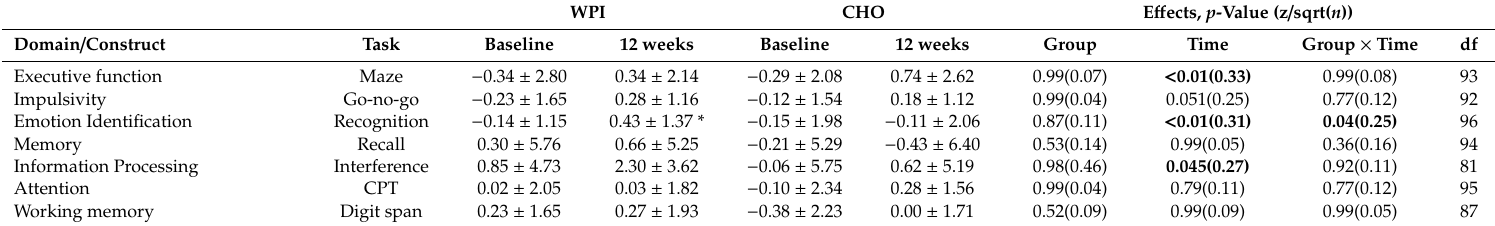
Table 5. Composite Z-scores across cognitive function domains in WPI vs. CHO at baseline and 12 weeks (mean ± SD). WPI CHO E ff ects, p -Value (z / sqrt( n )) Domain / Construct Task